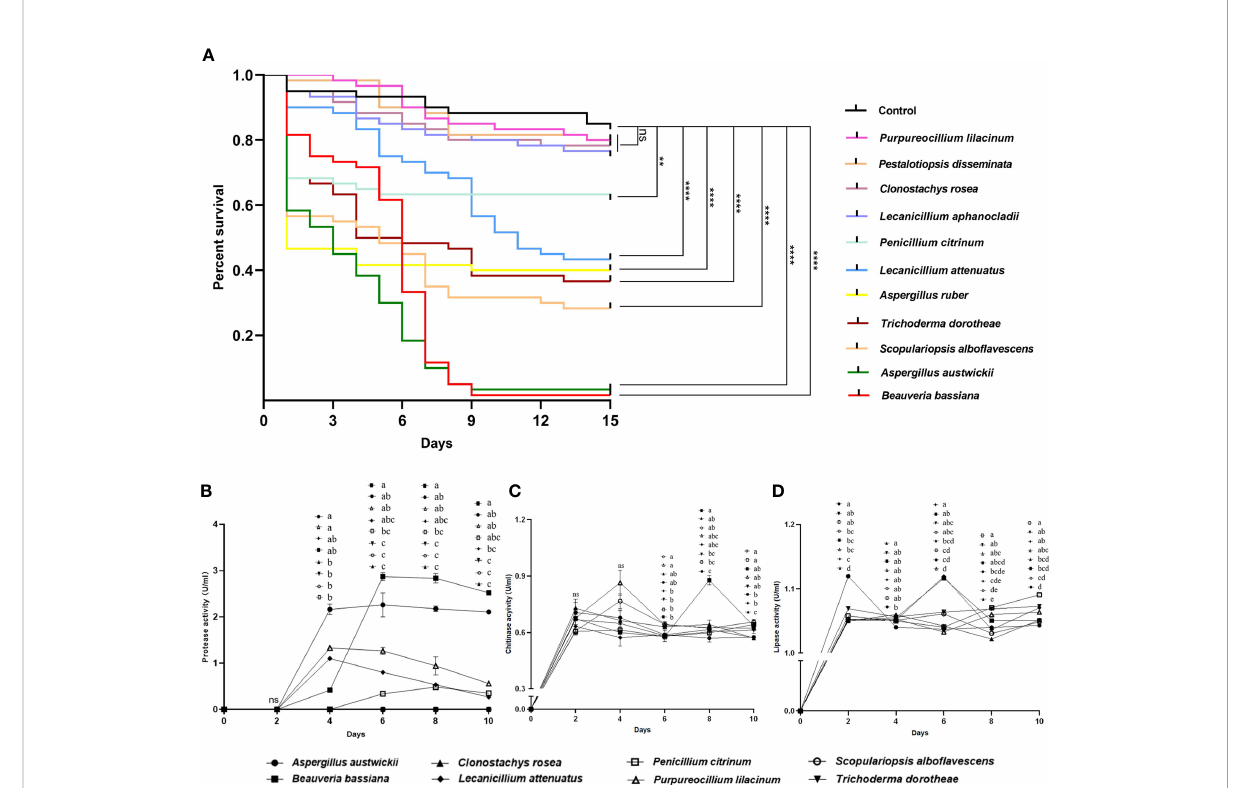
FIGURE 2 Entomopathogenic activities of representative fungal species isolated from M . alternatus populations with naturally fungal infection. (A) Kaplan- Meier survival curves of T . castaneum beetles inoculated with conidia suspension (1×10 8 conidia/ml). Log-rank tests were performed and the levels of differences were denoted: ns, not signi fi cant, P > 0.05; ** P< 0.01; **** P< 0.0001. (B) Protease activities of fermentation supernatants from fungal species. (C) Chitinase activities of fermentation supernatants from fungal species. (D) Lipase activities of fermentation supernatants from fungal species. In B-D, different letters mean signi fi cant differences among fungi at each time point ( P< 0.05) and ns means not signi fi cant. Data were represented as Mean ±